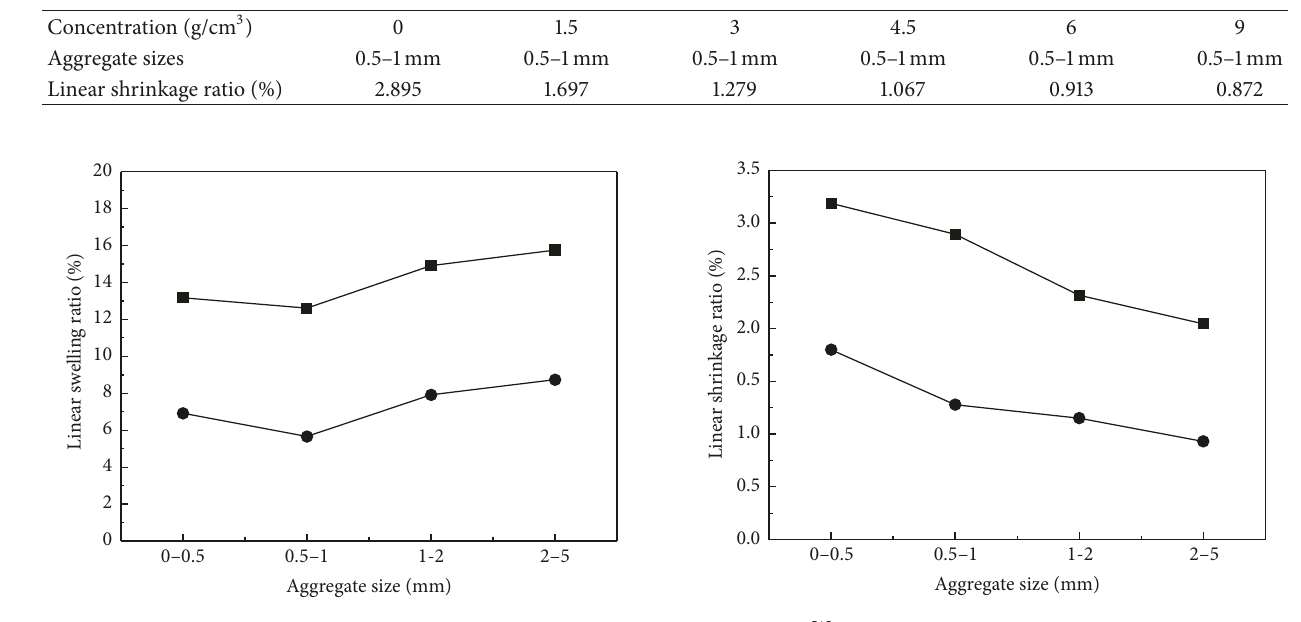
Table 5: The linear shrinkage ratio of specimens with different concentration of PVA.